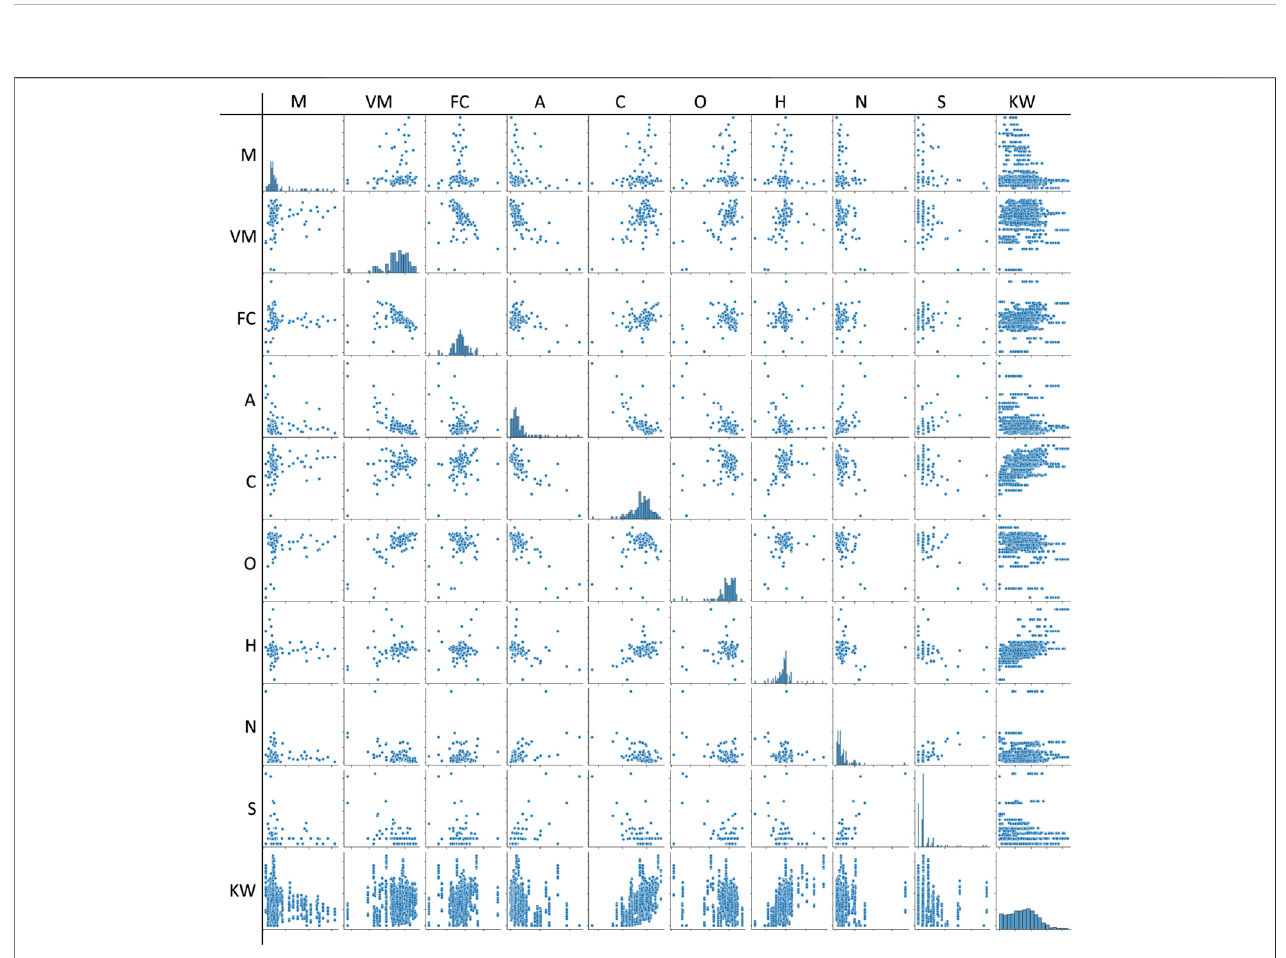
FIGURE 4 | Dataset inter-parameters